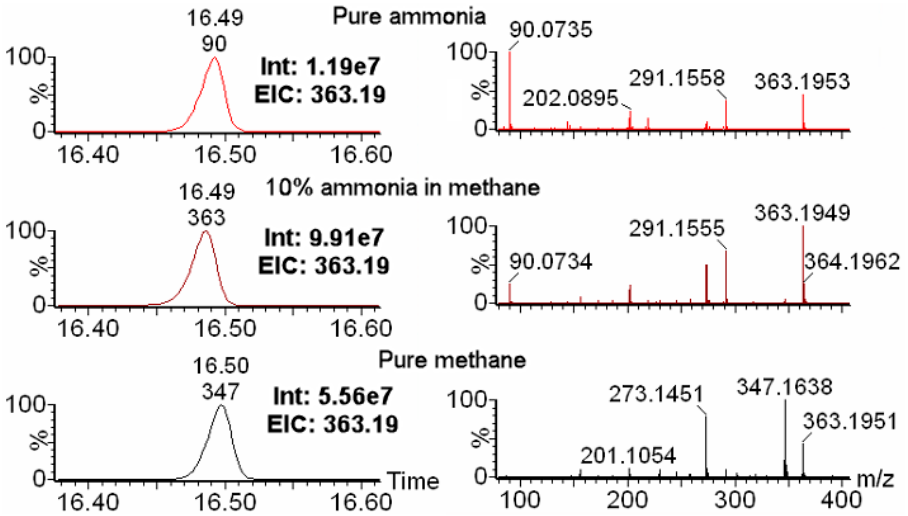
Figure 1. Comparison among three different CI reagent gases. Three reagent gases (pure ammonia (top in red color), 10% ammonia in methane (middle in purple color), and pure methane (bottom in black color)) in positive CI were compared for analysis with unlabeled S. cerevisiae extract samples. The left panels are the extracted ion chromatograms (EIC) for the [MH] + ion of triple-silylated glutamine with m/z of 363.195. 10% ammonia in methane showed highest intensity (Int) of the EICs. The right panels are mass spectra of glutamine under three different reagent gases. Pure ammonia showed highest intensity artifact m/z peak of 90.0735, pure methane showed highest intensity of MH-CH 4 fragment ion (347.1638), while 10% ammonia in methane showed highest intensity of [MH] + ion of triple-silylated glutamine